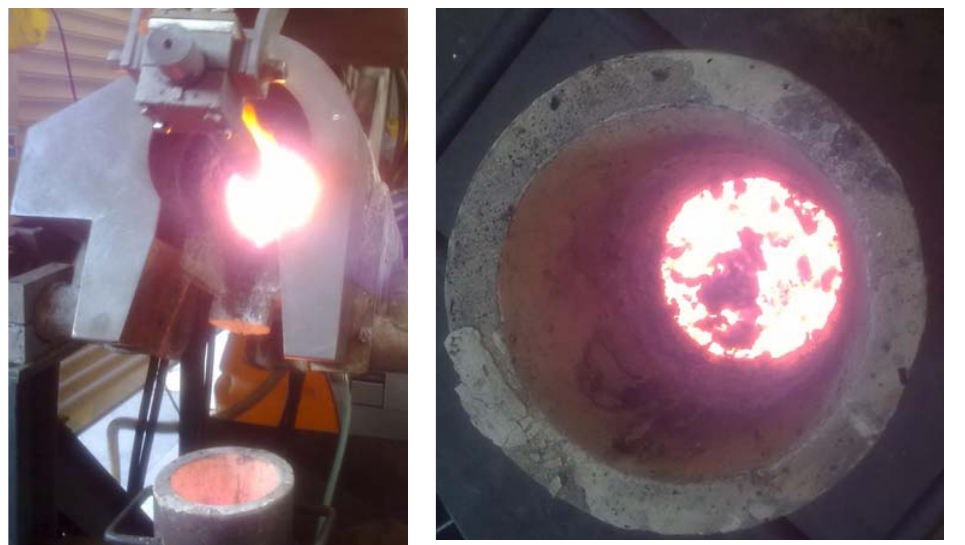
ladle with the resultant slag